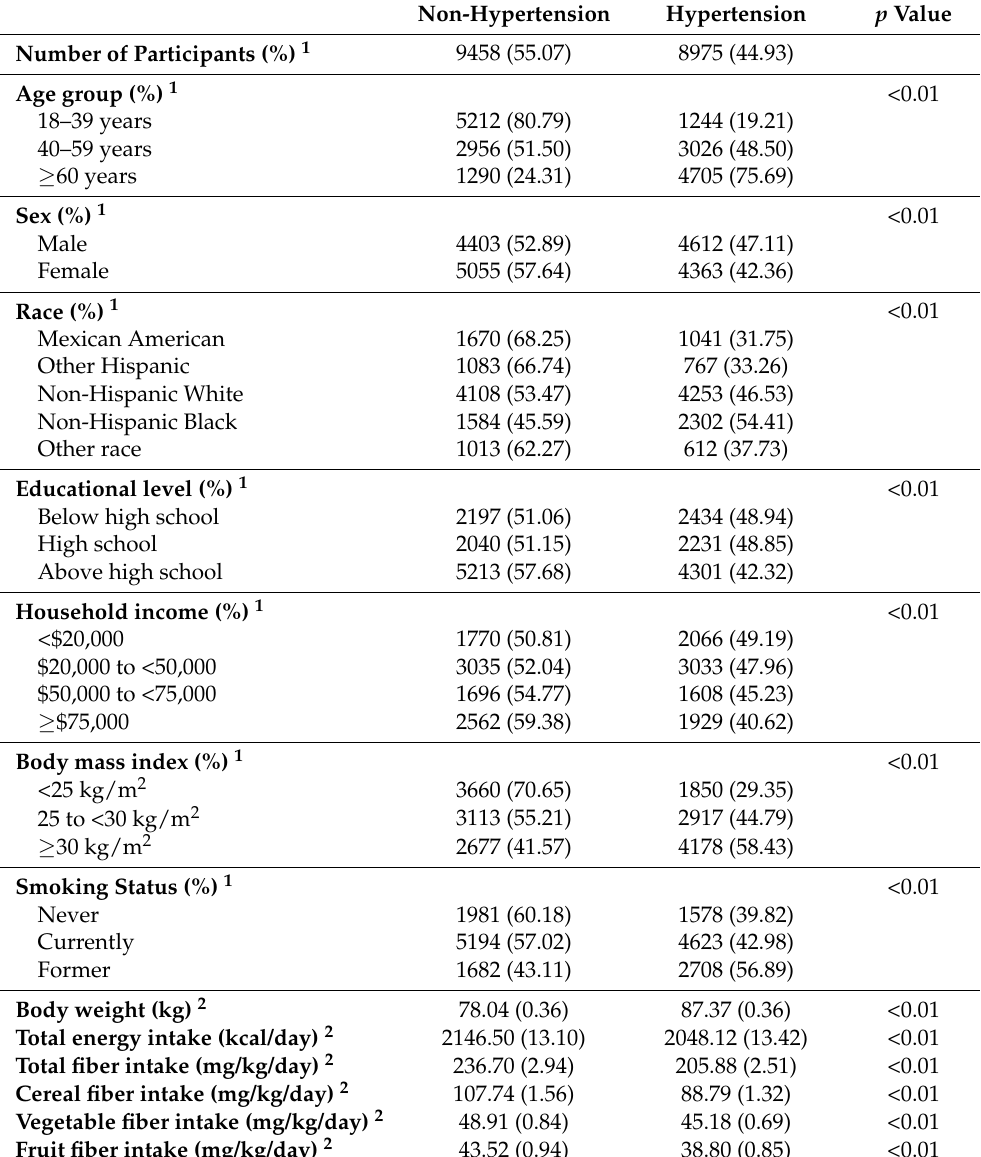
Table 1. Characteristics of participants by hypertension, NHANES 2007–2014, adults ≥ 18 years of